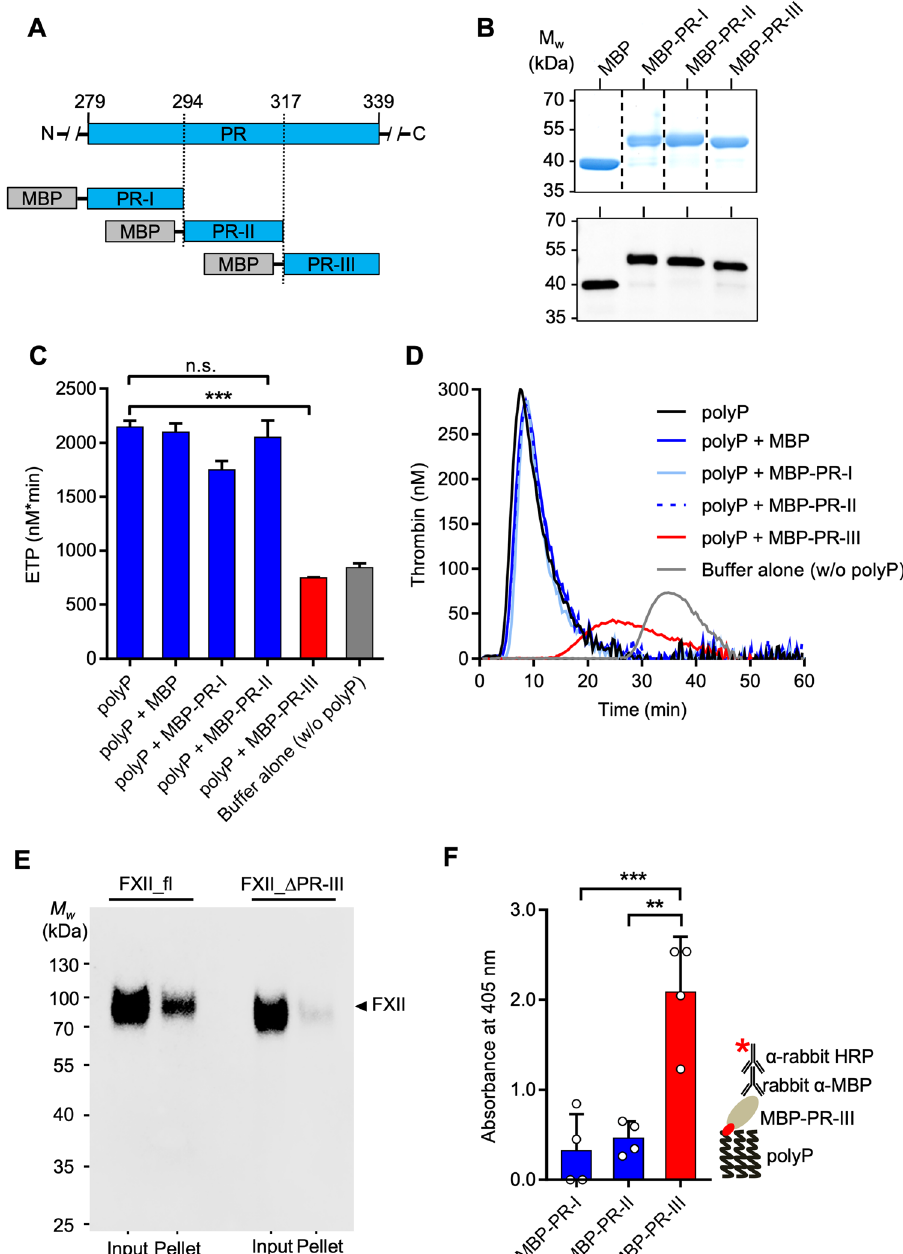
Fig. 4 The PR-III sequence mediates FXII contact activation. A Schematic overview of maltose binding protein (MBP) fused to PR-I, PR-II or PR-III forming MBP-PR-I, MBP-PR-II and MBP-PR-III, respectively. B Analysis of puri fi ed MBP, MBP-PR-I, MBP-PR-II and MBP-PR-III using Coomassie blue-stained reducing SDS-PAGE (top panel, 2 µ g protein/lane) or western blotting with an anti-MBP antibody (bottom panel, 40 ng protein/lane). n = 2. C ETP of normal PPP stimulated with long-chain polyP (5 μ g/mL), incubated with MBP, MBP-PR-I, MBP-PR-II or MBP-PR-III (600 nM), or buffer alone (no polyP), n = 3 run in triplicate each. n.s.: non-signi fi cant, ***: P < 0.001 vs. polyP by one-way ANOVA and Dunnett´s multiple comparison test. D Representative real time thrombin generation curves of C . E Pulldown of FXII_ fl and FXII_ Δ PR-III with kaolin. Input and washed pellet were probed by anti-FXII antibodies in western blotting. One blot of n = 2. F Binding of MBP-PR-I, MBP-PR-II, and MBP-PR-III to immobilized polyP. Bound proteins were quanti fi ed photometrically using anti-MBP and HRP-coupled detection antibodies followed by substrate reaction. Inset: Schematic representation of the ELISA assay. n = 4. ***: P = 0.0006, **: P = 0.001 by one-way ANOVA and Dunnett´s multiple comparison test. Mean values ± SD. HRP: horseradish